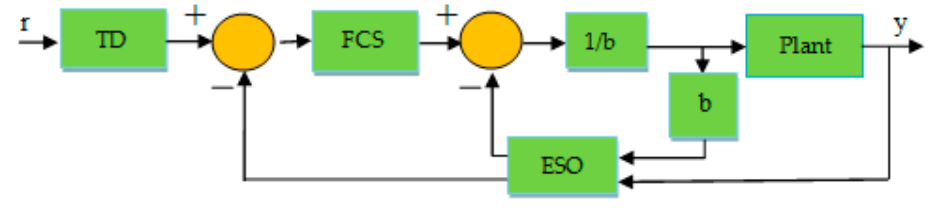
Figure 1. Architecture of ADRC.